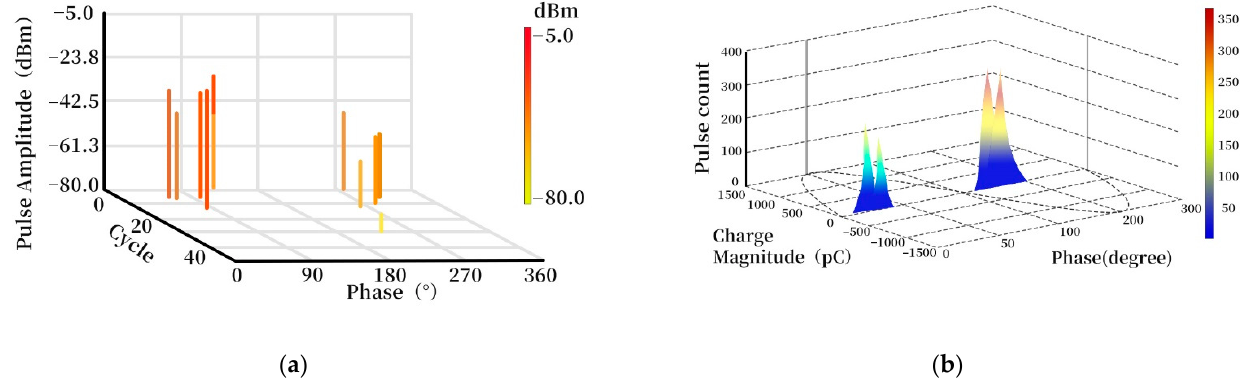
Figure 9. ( a ) Typical example of PRPS. Reprinted from Ref [111]. ( b ) typical example of PRPD. Reprinted from Ref [135].